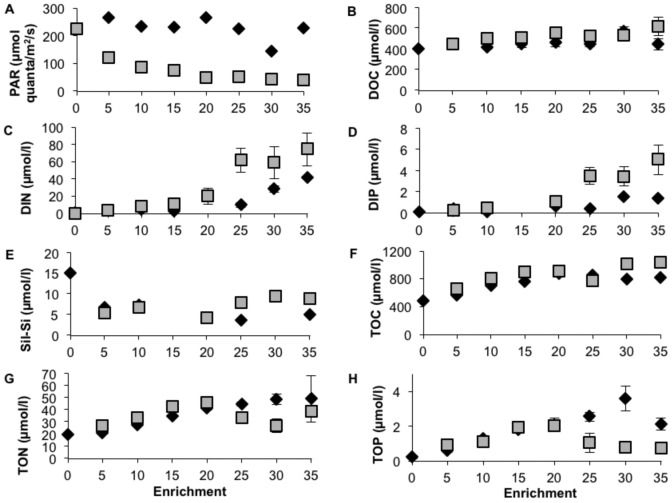
Mean values of PAR light (a), DOC (b), DIN (c), DIP (d) and Sil-Si (e), TOC (f), TON (g) and TOP (h) for NP (⧫) and CNP (▪) treatments sampled during the final two weeks of the mesocosm experiment.Error bars are standard error (n = 2).